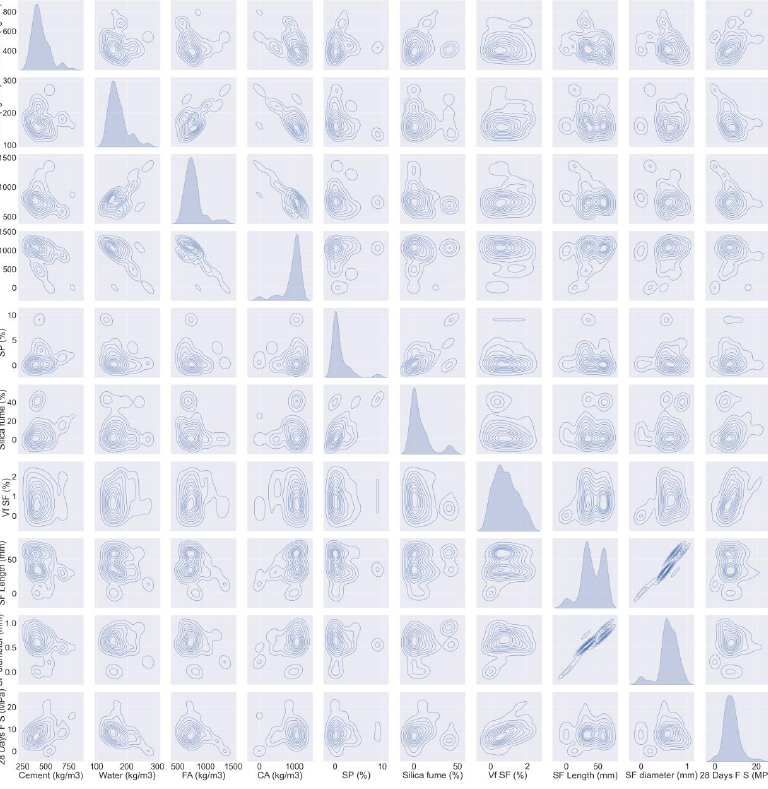
Figure 3. Data description of flexural